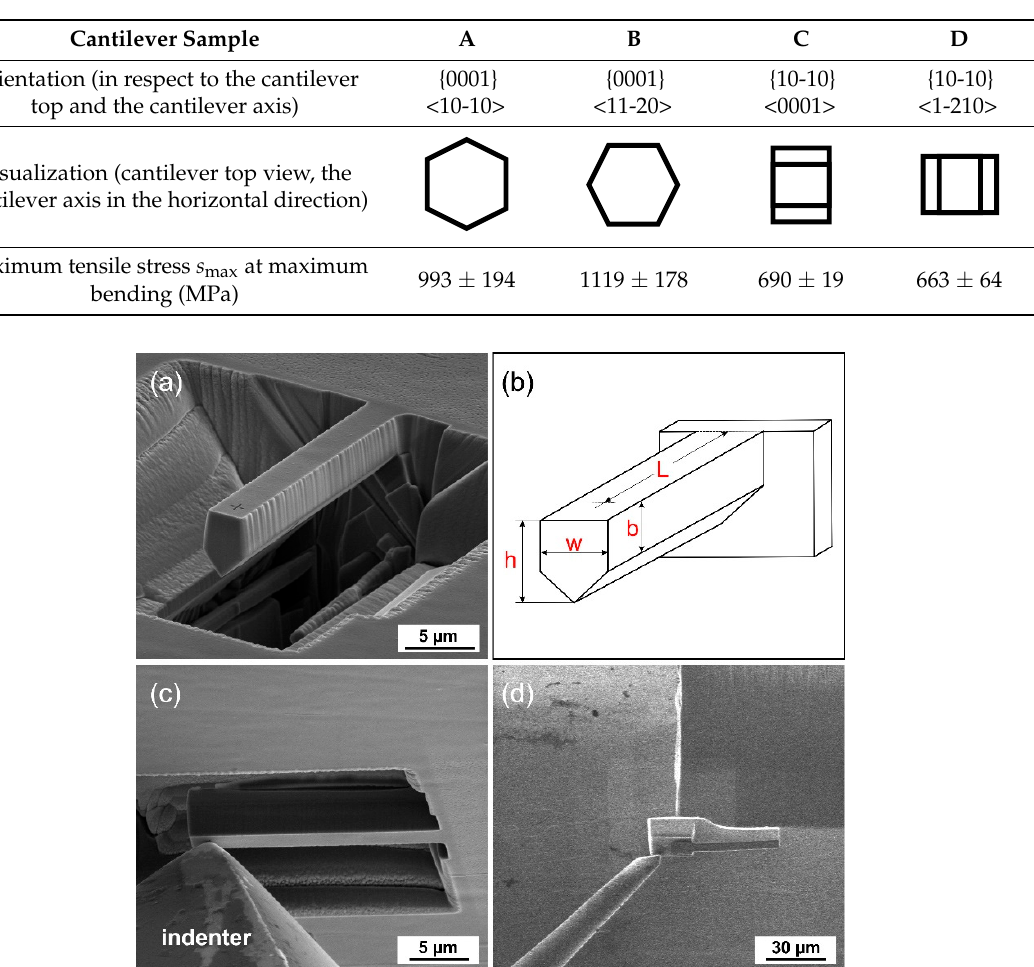
Table 1. The crystallographic orientations in samples A, B, C, and D, and maximum tensile stresses due to bending.